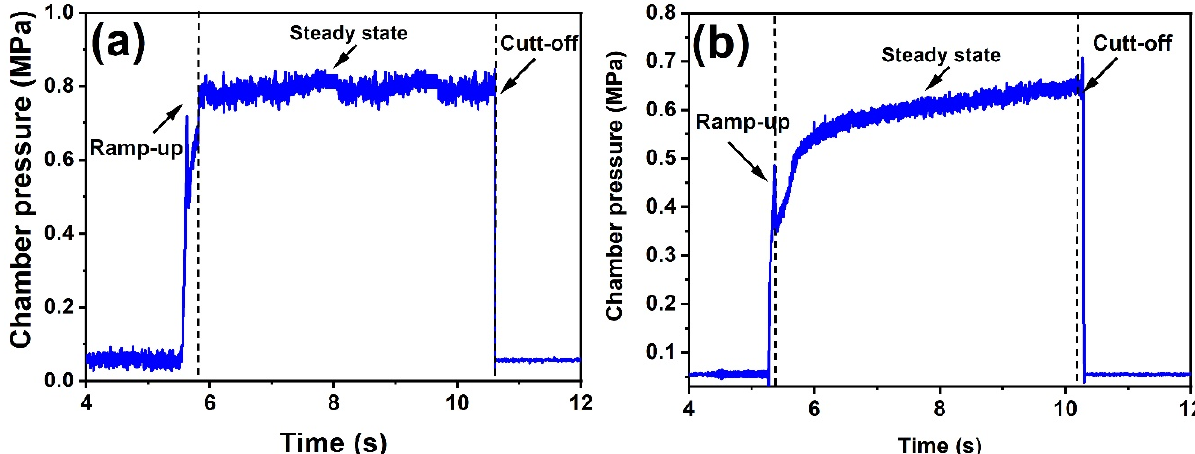
Figure 9. Combustion chamber pressure of ( a ) pure beeswax and ( b ) 80% beeswax + 20% EVA.